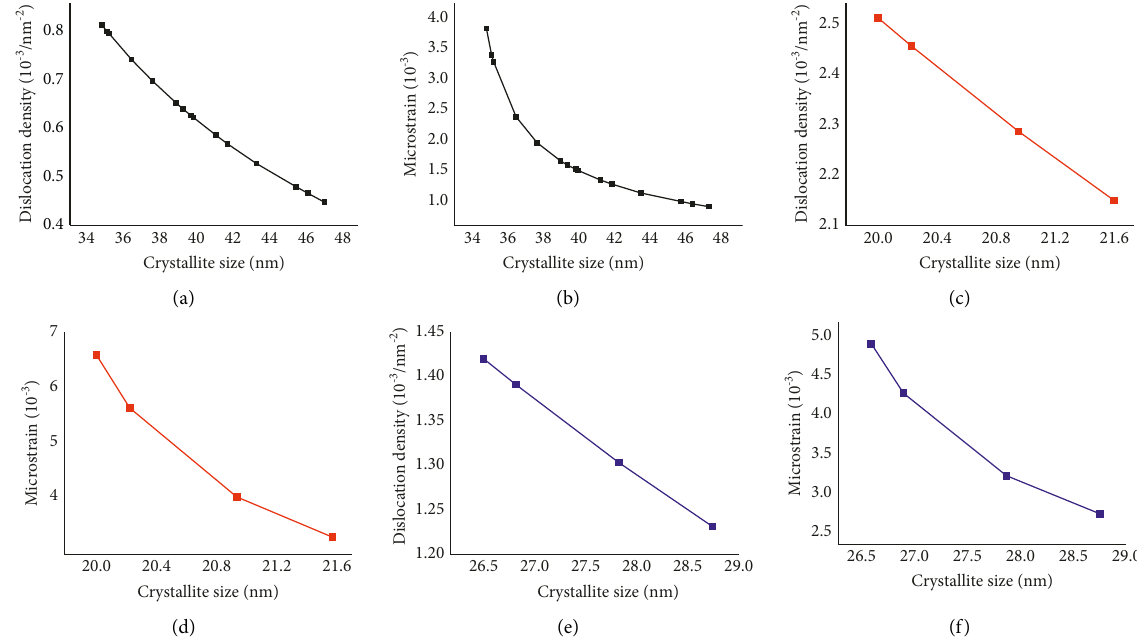
Figure 10: Variation of dislocation density and microstrain with the crystallite size of NiS thin films obtained by spin-coating at 200 ° C, 300 ° C, and 400 °